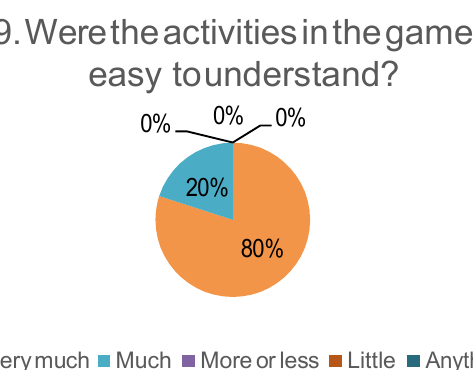
Figure 2. Ease of adaptation to Myo. Figure 3. Ease to understand the game.